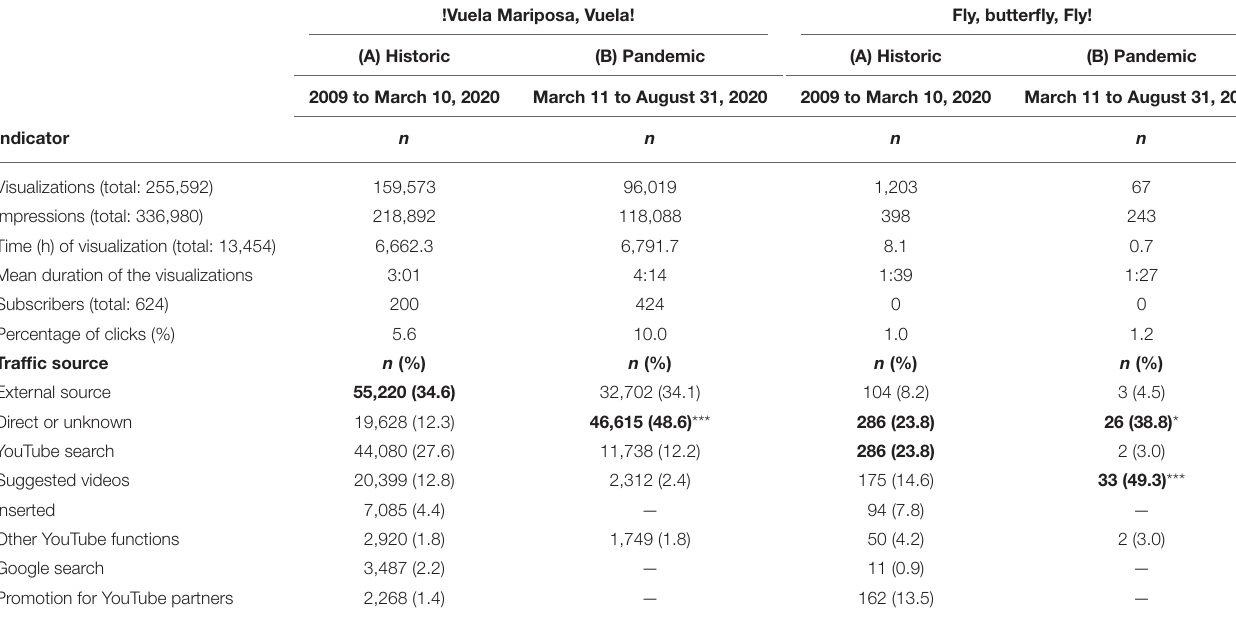
TABLE 1 | Comparative analysis on the use of the children’s story on cycle of life, death, and grief—indicators and traffic sources.